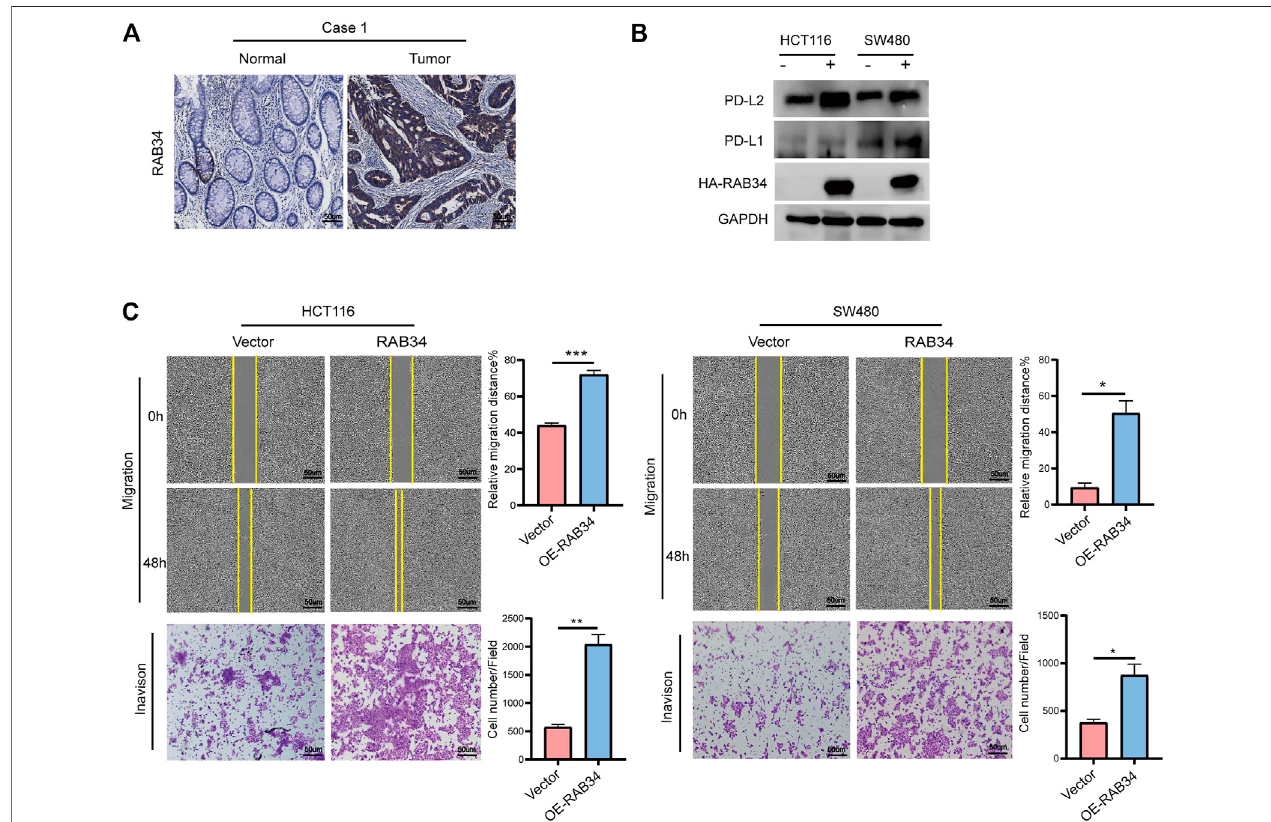
FIGURE 8 | Overexpression of RAB34 increased PD-L1 and PD-L2 expression of CRC. (A) Immunohistochemical staining of patients with colorectal cancer. (B) OverexpressionofRAB34analyzedtheproteinlevelsofPDL-1andPD-L2intheHCT16cellsandSW480cells. (C) OverexpressionofRAB34analyzedthemigrationand invasion in the HCT16 cells and SW480 cells. * p < .05, ** p < .01, *** p <